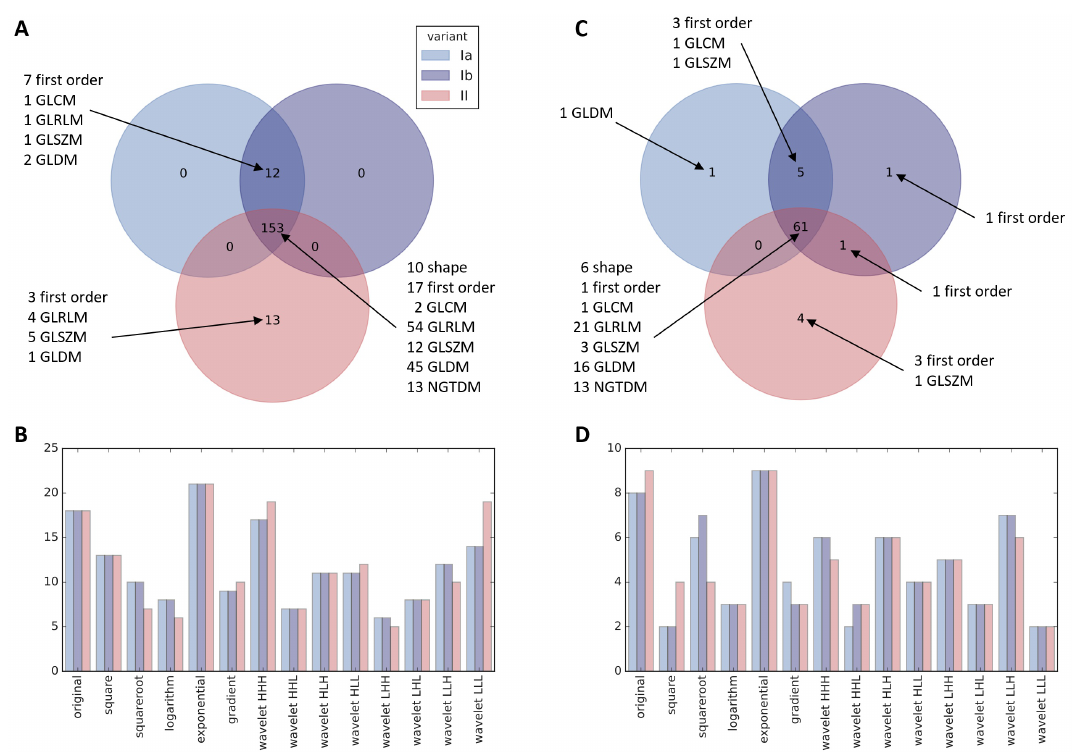
Figure 3. Features with FDR < 0.1 in univariate analysis grouped by radiomics category ( A ) and by image filter ( B ). Features selected for model grouped by radiomics category ( C ) and by image filter ( D